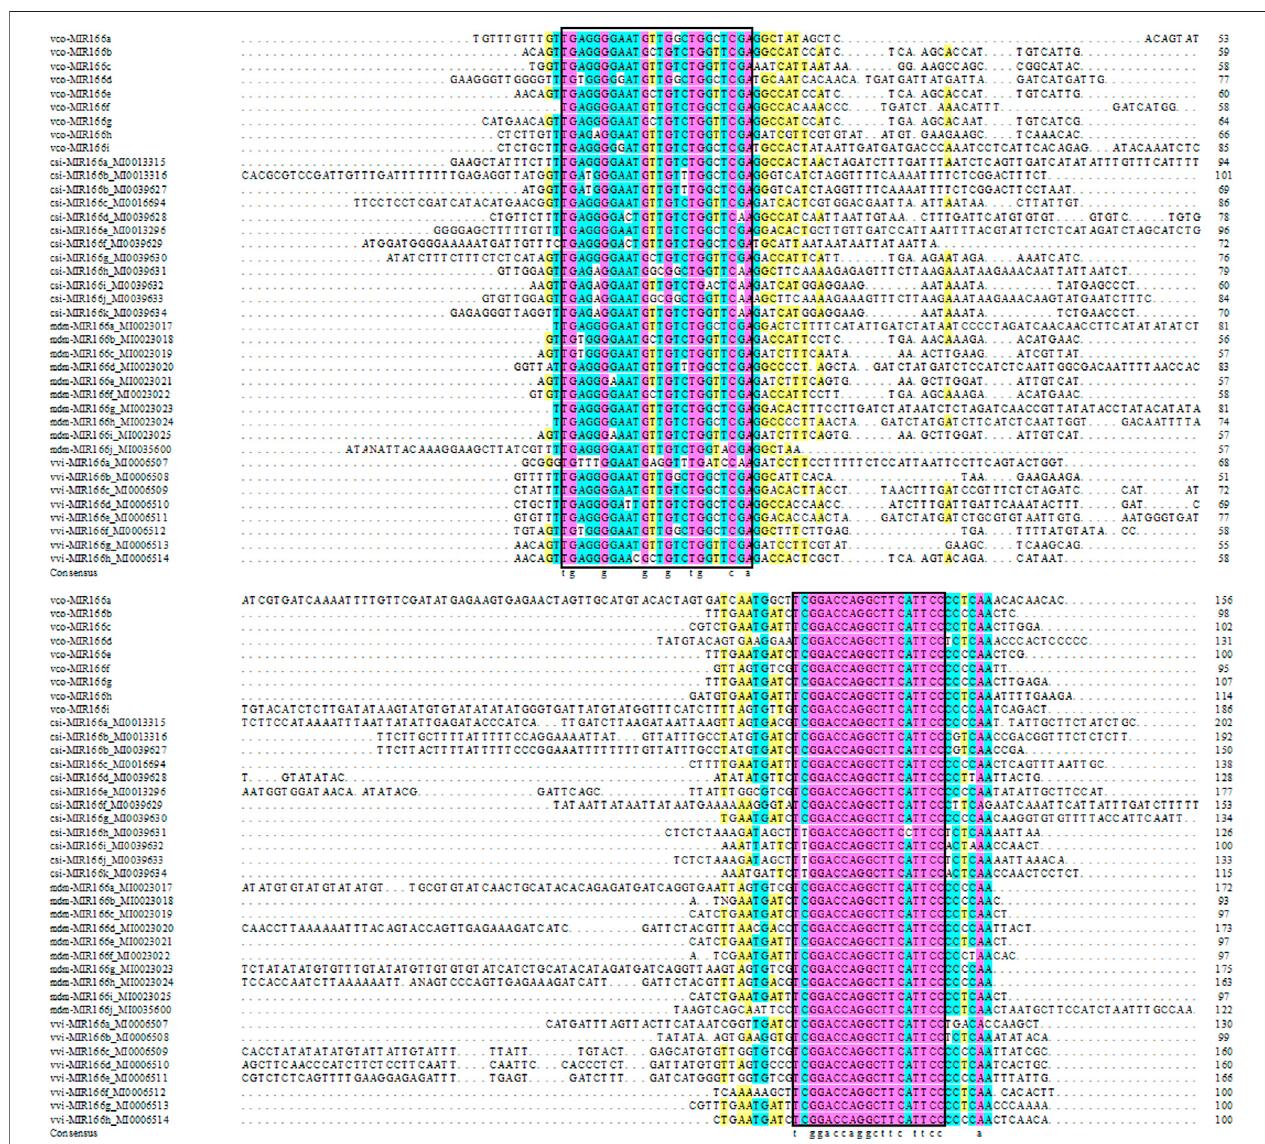
FIGURE 1 | Sequence alignment of miR166 precursors. Vco, Vaccinium corymbosum ; Csi, Citrus sinensis ; Vvi, Vitis vinifera ; Mdm, Malus domestic . Pink, 100% conservation; green, ≥ 75% conservation; yellow, ≥ 50% conservation. The core region of the mature miRNA is indicated in the black box.